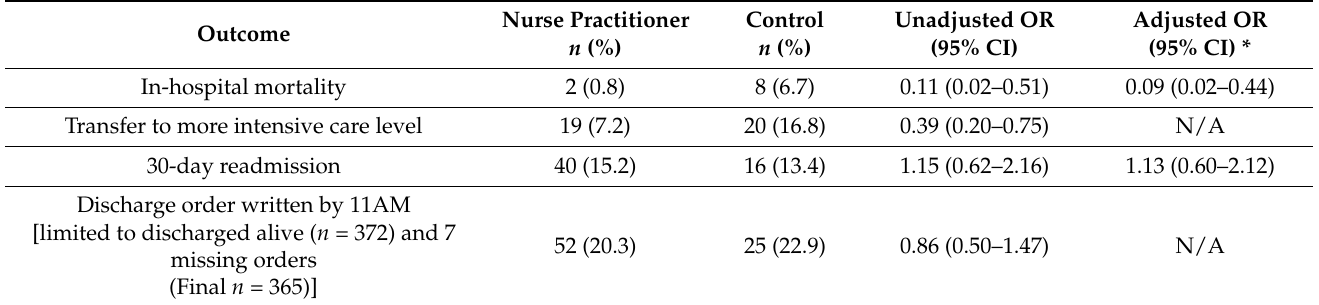
Table 2. Outcome Measures of Dichotomous